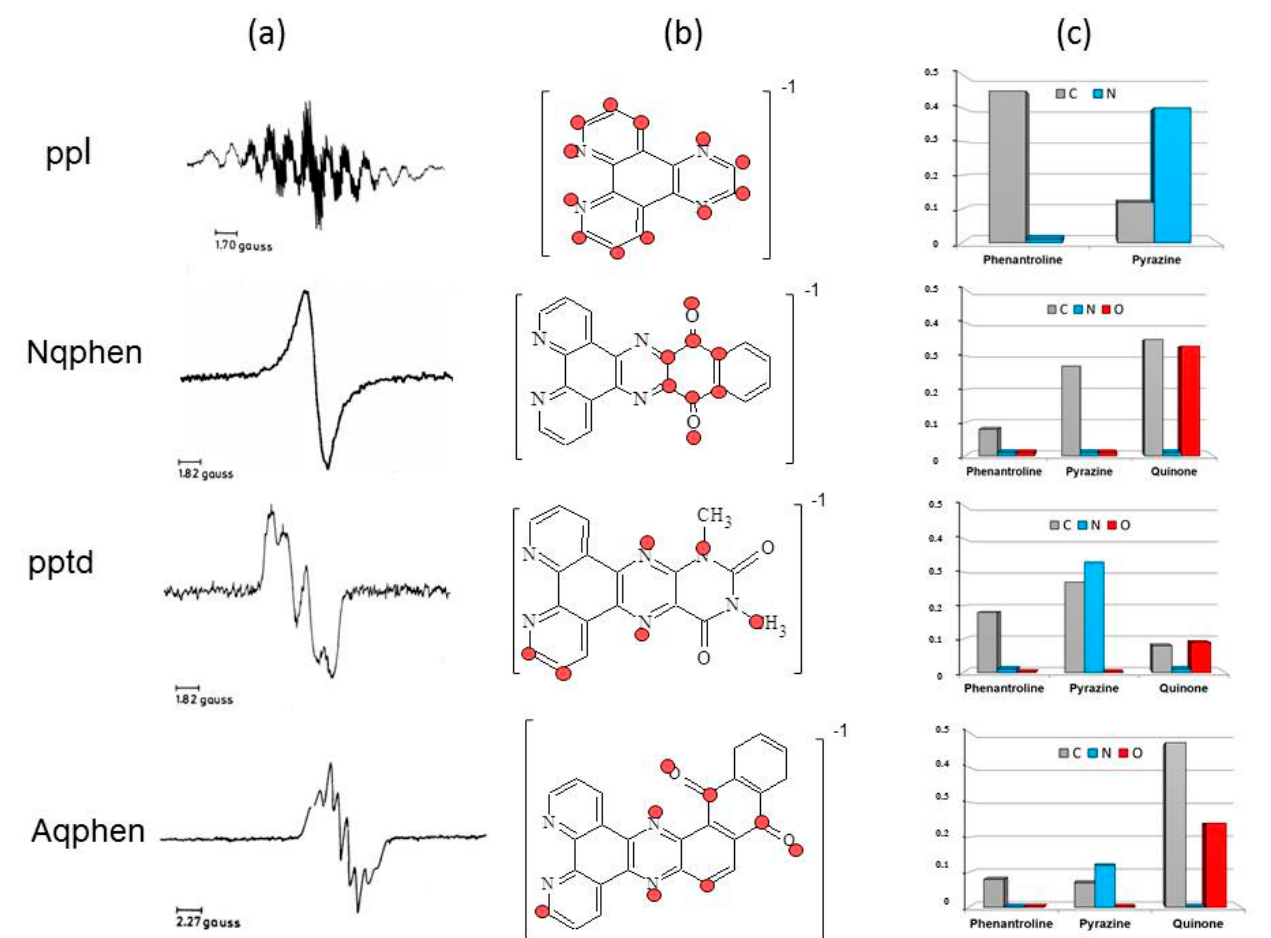
Figure 4. ( a ) Simulated ESR spectrum of the free radicals of the ligands, prepared “in situ” by electrochemical reduction in the cavity of an EPR instrument. ( b ) Nucleus which interacts with the unpaired electron according the EPR data. ( c ) The Fukui function, Equation (2), for the different fragment components.